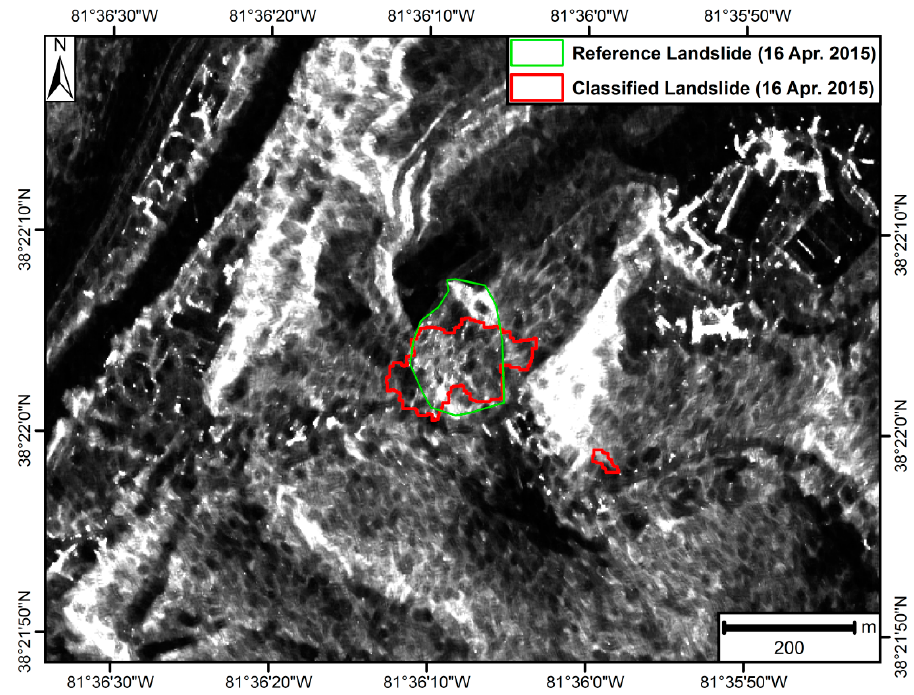
Figure 6. Result (red) of the landslide detection procedure at the Yeager Airport based on post-event dual-pol TerraSAR-X (acquired on 16 April 2015; background image) and pre-event optical Landsat-8 (15 January 2015) imagery. The green polygon marks the reference landslide derived by visual interpretation and manual digitization of the TerraSAR-X imagery. TerraSAR-X © 2015 German Aerospace Center (DLR), 2015 Airbus Defence and Space/Infoterra GmbH. Table 2. Classification accuracies for the Yeager Airport landslide (12 March and 13 April 2015).